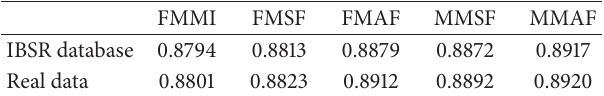
Table 4: Comparison of the overlap values for various methods. FMMI FMSF